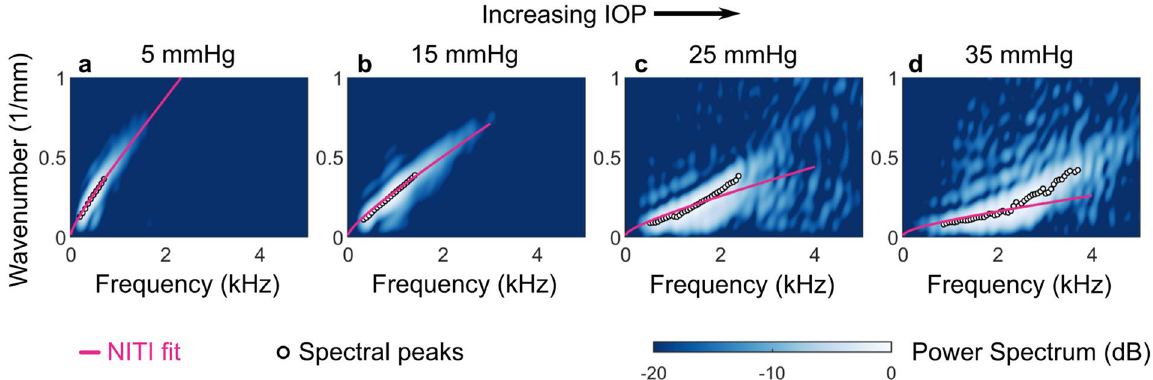
Figure 7. Nonlinear and anisotropic behavior becomes increasingly complex at high intraocular pressure (IOP). 2D Fourier spectra of wave fields generated and tracked with AμT-OCE along the surface of porcine cornea at varying intraocular pressure (IOP) show increasingly complex behavior as IOP increases. Spectra are displayed on a log scale over a 20 dB display dynamic range with spectral peaks (circles) and best-fit dispersion curves for NITI model (pink) at 5 mmHg IOP ( a ), 15 mmHg IOP ( b ), 25 mmHg IOP ( c ), and 35 mmHg IOP ( d